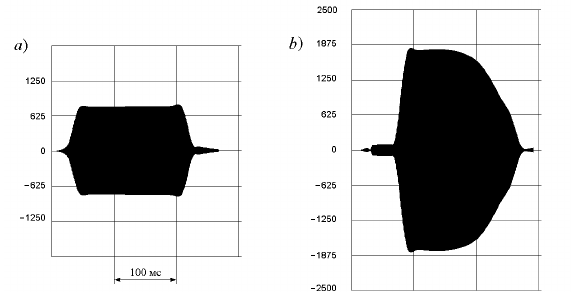
Fig. 4. The signal at the output of the layout of the radio pulse converter for F T > 2 F Ω ( a ) and in phase-sensitive mode ( b ) at F T = 2 F Ω (the scale is indicated in the ADC